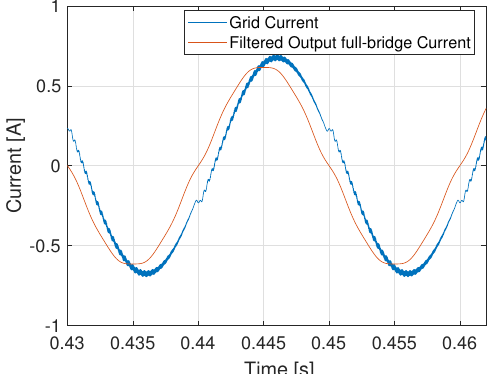
Figure 4. Comparison between the output full-bridge current, zero-phase filtered to remove the Pulse Width Modulation (PWM) components (orange) and an actual injected grid current (blue) in order to highlight the phase shift introduced by the output Capacitive-Inductive CL filter.